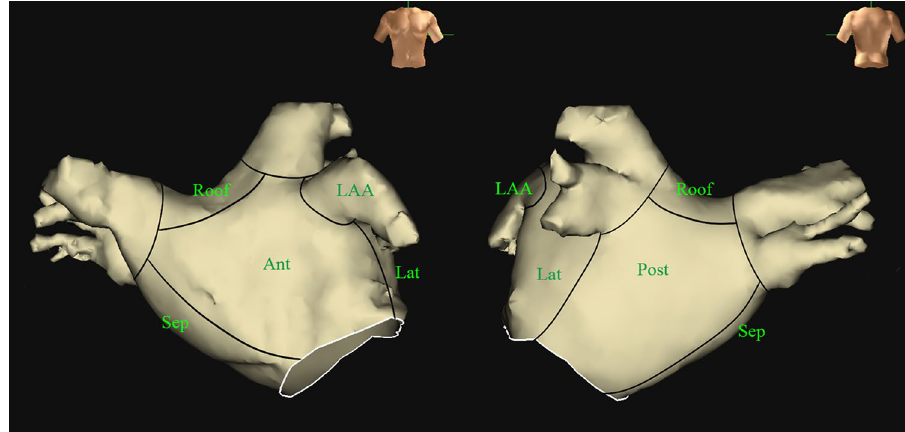
Figure 3. Segment of left atrium. (Graphics software: Ensite elocity). Ant, anterior wall; Lat, lateral wall; LAA, left atrial appendage; Post, posterior wall; Sep, septum.